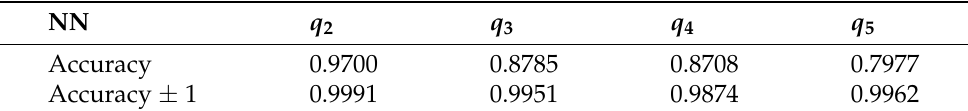
Table 5. Accuracy for prediction with NN.